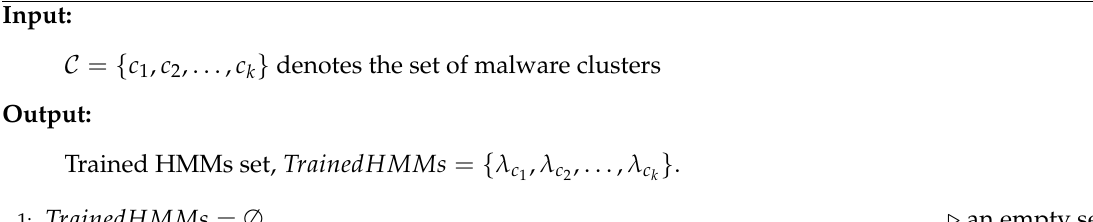
Algorithm 2 : HM 3 alD -Training